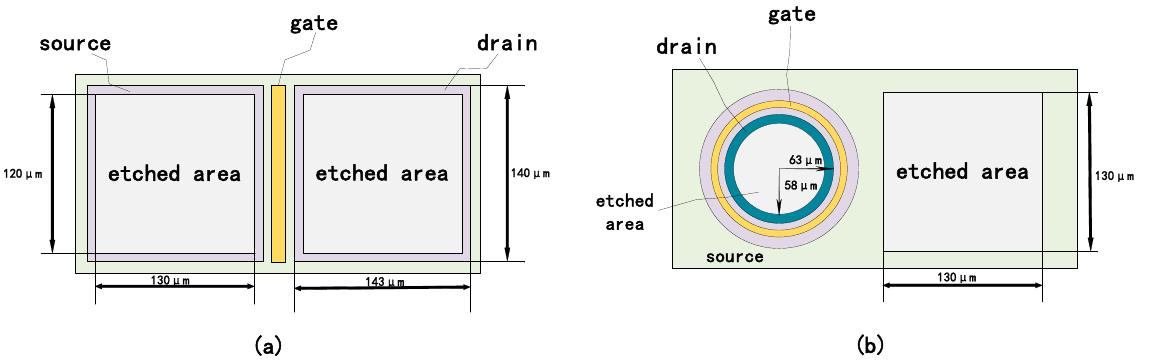
Figure 5. ( a ) Schematic diagram of the etched area under the source and drain of the conventional structure device and ( b ) ring-gate structure device.